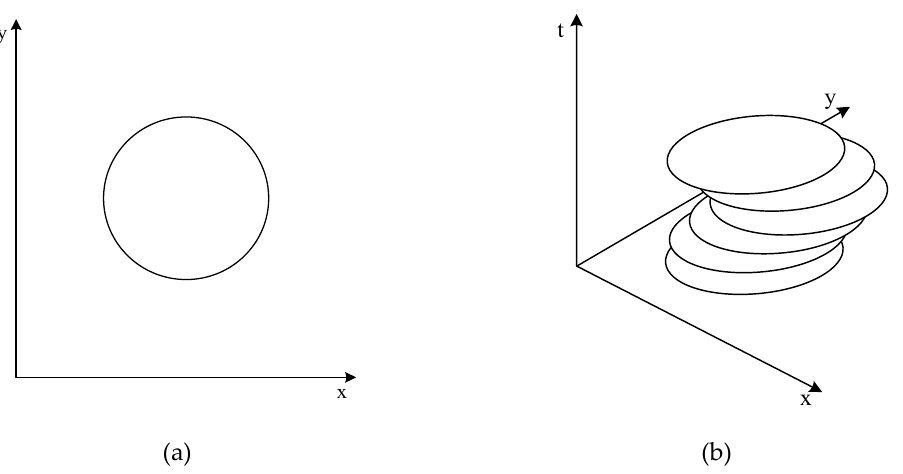
Figure 2. Illustrations of the obstacle having different obstacle type: ( a ) Static obstacle; and, ( b ) Dynamic obstacle.